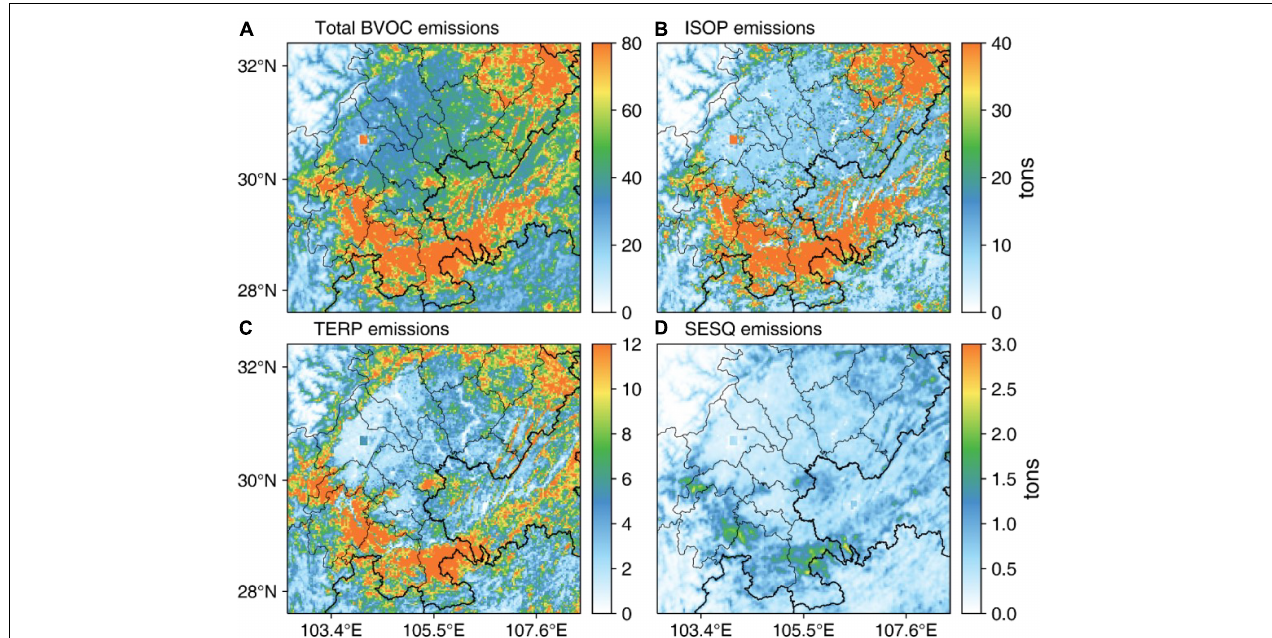
FIGURE 3 | Annual emissions of total BVOC (A) , isoprene (B) , monoterpenes (C) , and sesquiterpenes (D) for 2017 estimated by MEGAN2.1.